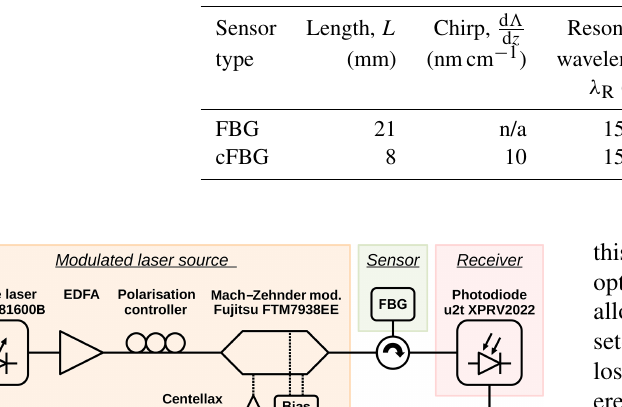
Table 1. Parameters of the sensors tested. “n/a” stands for not applicable.